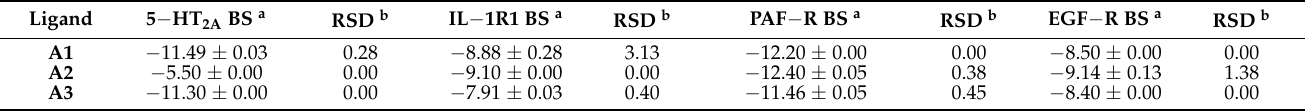
Table 1. Molecular docking results of Group A